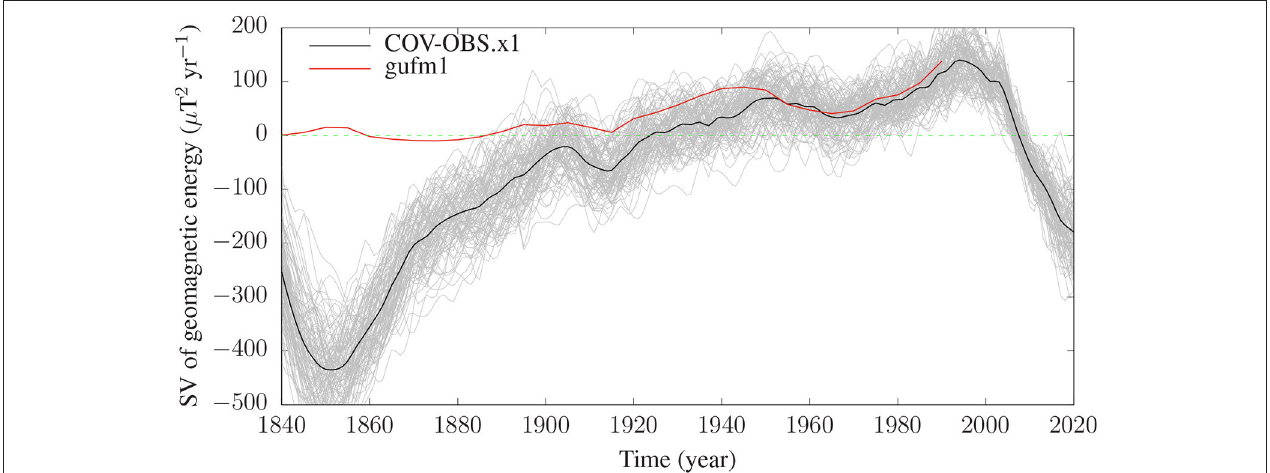
FIGURE 2 | The SV of the total geomagnetic energy on the CMB ˙ E b as a function of time for gufm1 in the period 1840–1990 (red; Jackson et al., 2000) and COV-OBS.x1 in the period 1840–2020 (black; Gillet et al., 2015). Gray lines correspond to the ensemble of 100 models of COV-OBS.x1. Dashed horizontal green line denotes zero. Note that the SV of the total geomagnetic energy is in units of µ T 2 yr − 1 .